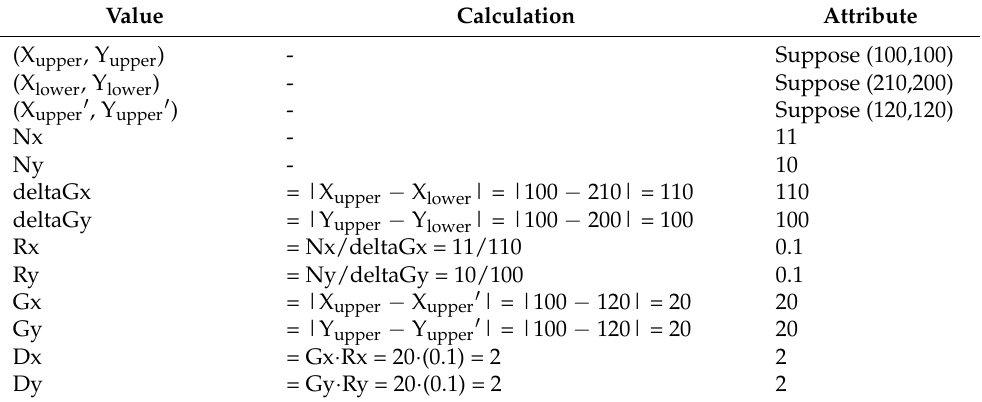
Table 4. Example of calculations.